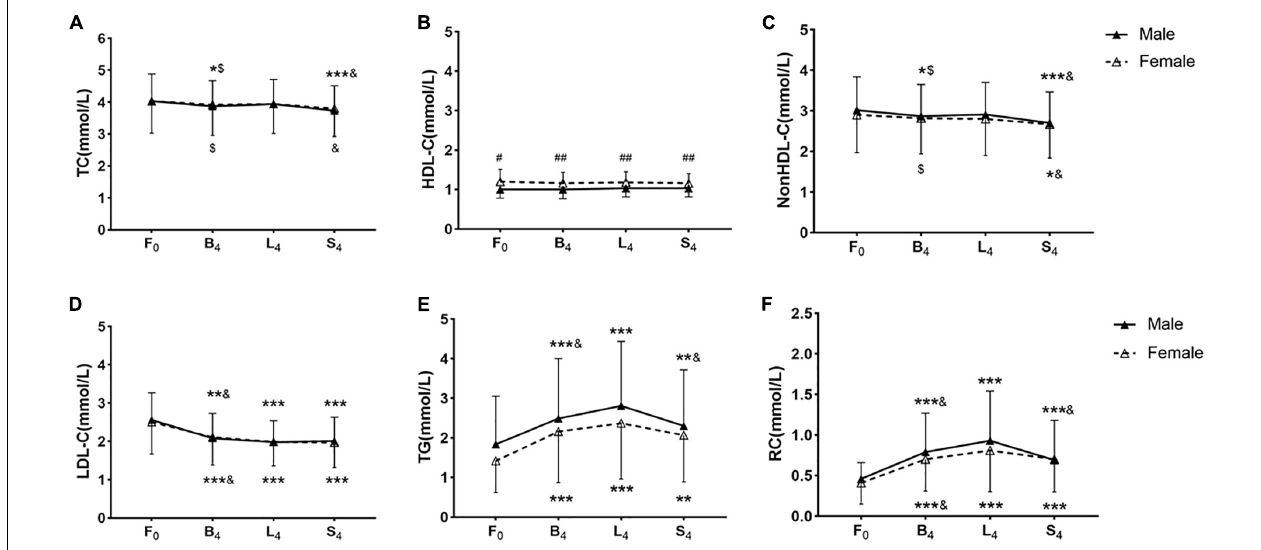
FIGURE 1 | Non-fasting blood lipid levels after three meals in the two groups. (A–F) Non-fasting changes in levels of TC (A) , HDL-C (B) , non-HDL-C (C) , LDL-C (D) , TG (E) , and RC (F) . Levels of non-HDL-C and RC were calculated and estimated, respectively. F 0 : at fasting state, B 4 : at 4 h after breakfast, L 4 : at 4 h after lunch, S 4 : at 4 h after supper. Cholesterol: 1 mmol/L = 38.7 mg/dL. TG: 1 mmol/L = 88.6 mg/dL. * p < 0.05, ** p < 0.01, and *** p < 0.001 when compared to the fasting level in the same group. $ p < 0.05 when compared to the level at 4 h after supper in the same group. & p < 0.05 when compared to the level at 4 h after lunch in the same group. # p < 0.05, ## p < 0.01 when compared to the female group at the same time-point.